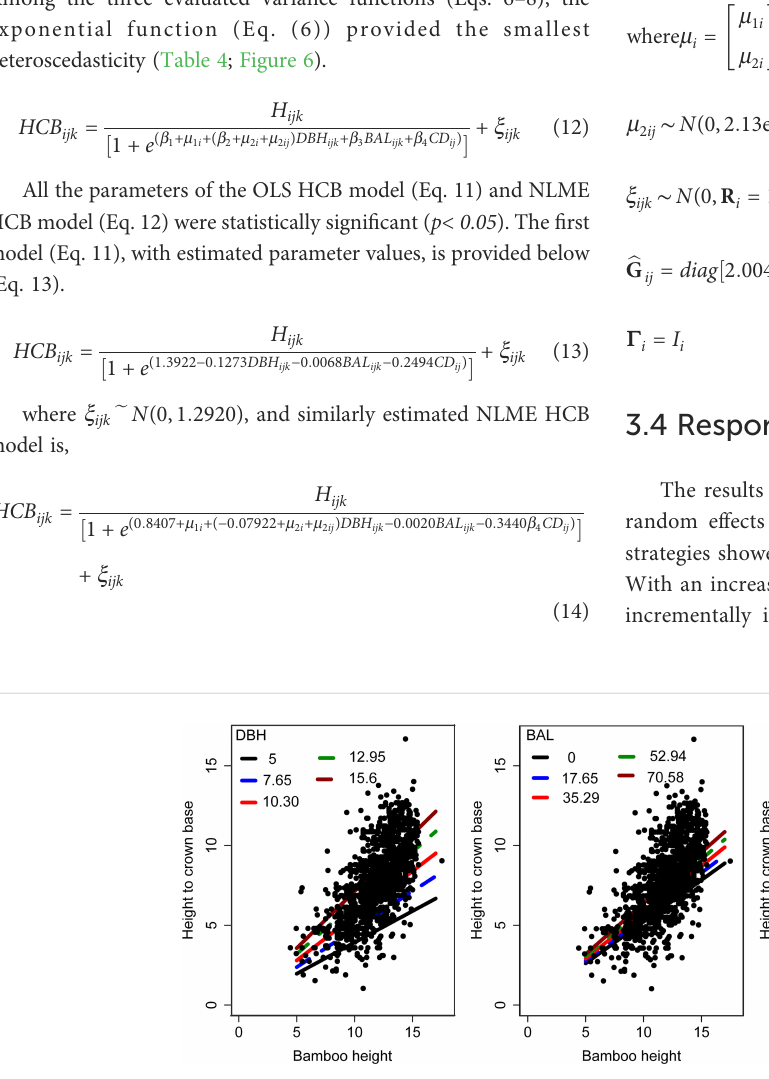
FIGURE 5 Base model (Eq. 11) simulation curves overlaid on scattered plot data (relationship between HCB and